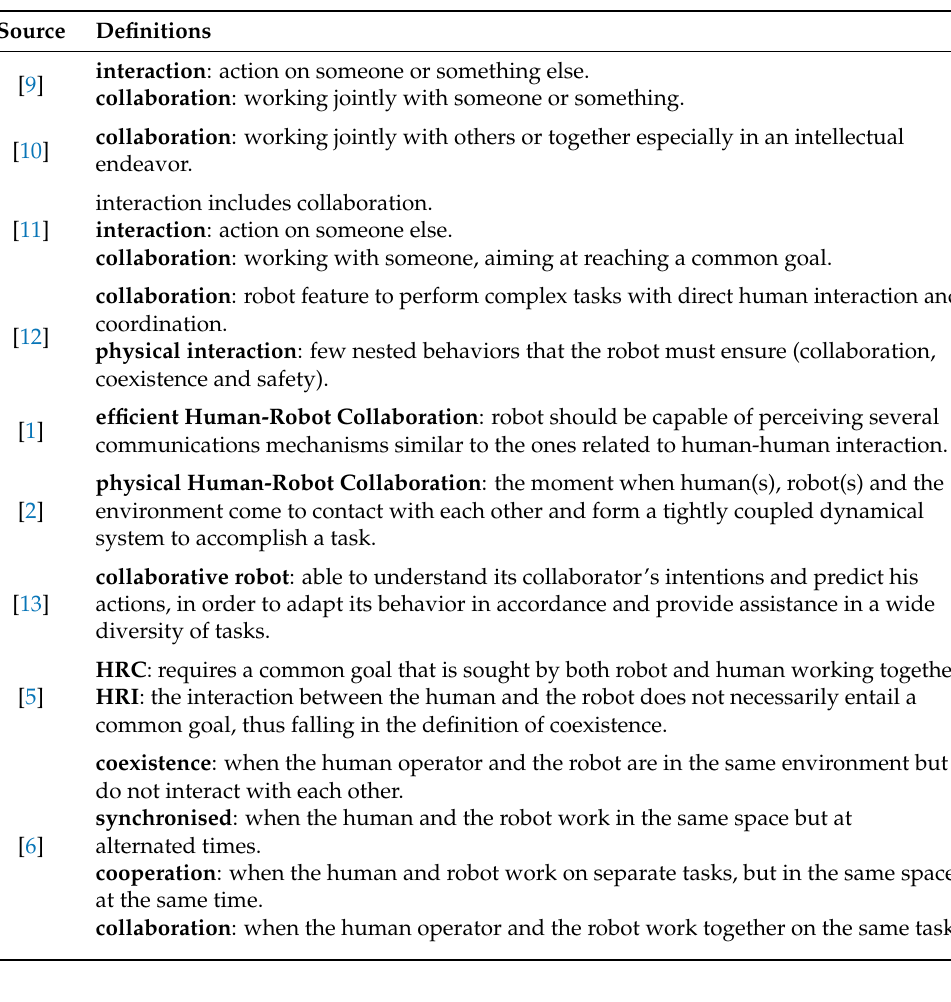
Table 1. Definitions regarding Human-Robot Collaboration and Human-Robot Interaction concepts, from several distinct